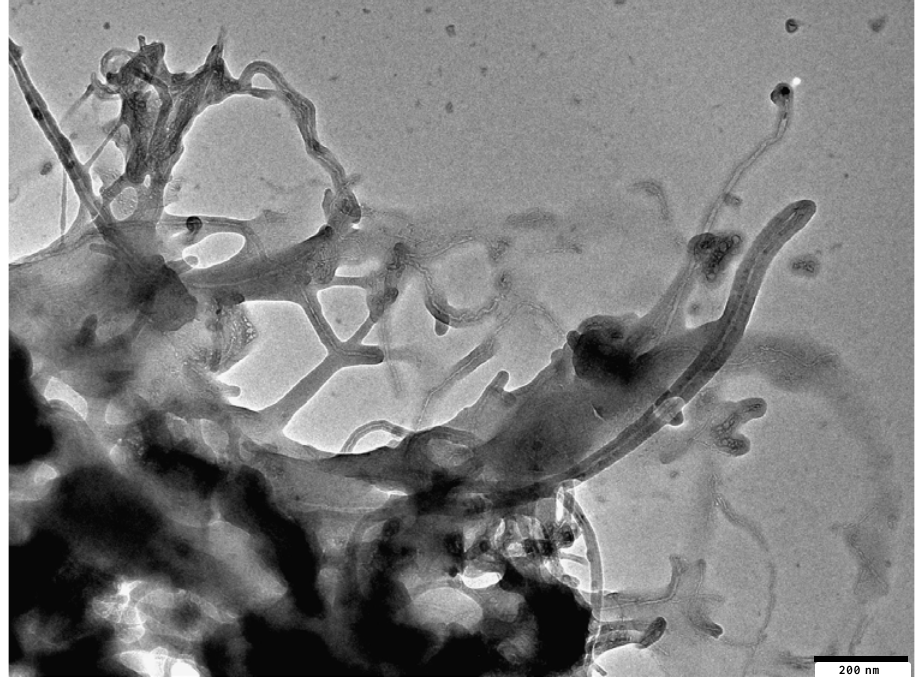
Figure 9. TEM image of polymer encapsulated ox. MWCNT. Almost every nanotube is covered by a thin and homogenous in-situ grown iPP film (about 10